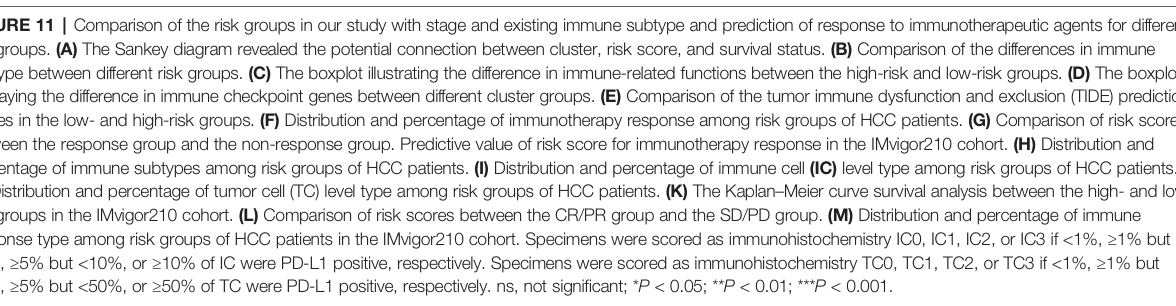
FIGURE 11 | Comparison of the risk groups in our study with stage and existing immune subtype and prediction of response to immunotherapeutic agents for different risk groups. (A) The Sankey diagram revealed the potential connection between cluster, risk score, and survival status. (B) Comparison of the differences in immune subtype between different risk groups. (C) The boxplot illustrating the difference in immune-related functions between the high-risk and low-risk groups. (D) The boxplot displaying the difference in immune checkpoint genes between different cluster groups. (E) Comparison of the tumor immune dysfunction and exclusion (TIDE) prediction scores in the low- and high-risk groups. (F) Distribution and percentage of immunotherapy response among risk groups of HCC patients. (G) Comparison of risk scores between the response group and the non-response group. Predictive value of risk score for immunotherapy response in the IMvigor210 cohort. (H) Distribution and percentage of immune subtypes among risk groups of HCC patients. (I) Distribution and percentage of immune cell (IC) level type among risk groups of HCC patients. (J) Distribution and percentage of tumor cell (TC) level type among risk groups of HCC patients. (K) The Kaplan – Meier curve survival analysis between the high- and low- risk groups in the IMvigor210 cohort. (L) Comparison of risk scores between the CR/PR group and the SD/PD group. (M) Distribution and percentage of immune response type among risk groups of HCC patients in the IMvigor210 cohort. Specimens were scored as immunohistochemistry IC0, IC1, IC2, or IC3 if <1%, ≥ 1% but <5%, ≥ 5% but <10%, or ≥ 10% of IC were PD-L1 positive, respectively. Specimens were scored as immunohistochemistry TC0, TC1, TC2, or TC3 if <1%, ≥ 1% but <5%, ≥ 5% but <50%, or ≥ 50% of TC were PD-L1 positive, respectively. ns, not signi fi cant; * P < 0.05; ** P < 0.01; *** P